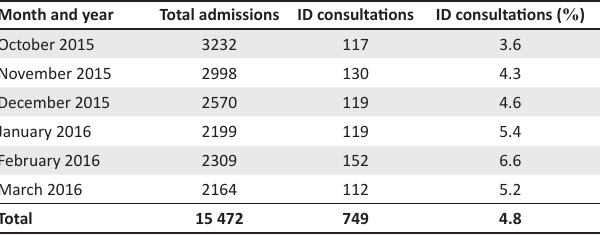
TABLE 1: Monthly infectious disease consultations as a percentage of total hospital admissions at Helen Joseph Hospital. Month and year